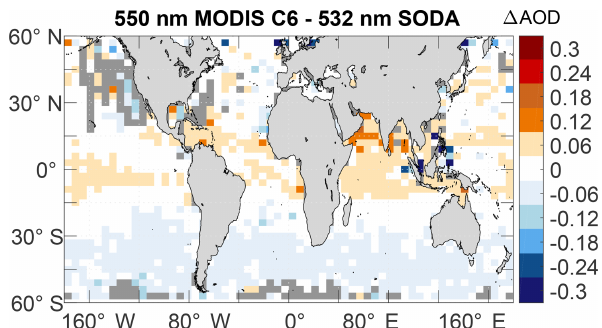
Figure 5. Mean AOD difference between matched 550nm MODIS C6 and 532nm SODA daytime AOD for 5 months of 2010. Oceanic regions with no available MODIS samples that meet the matching criteria are depicted in dark